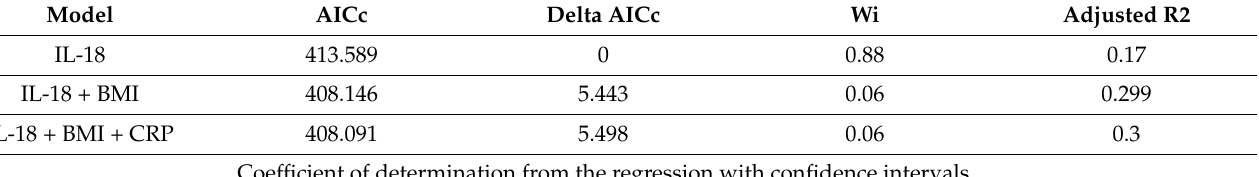
Table 4. Linear regression model for TG levels in perPsA. group ( n = 47).